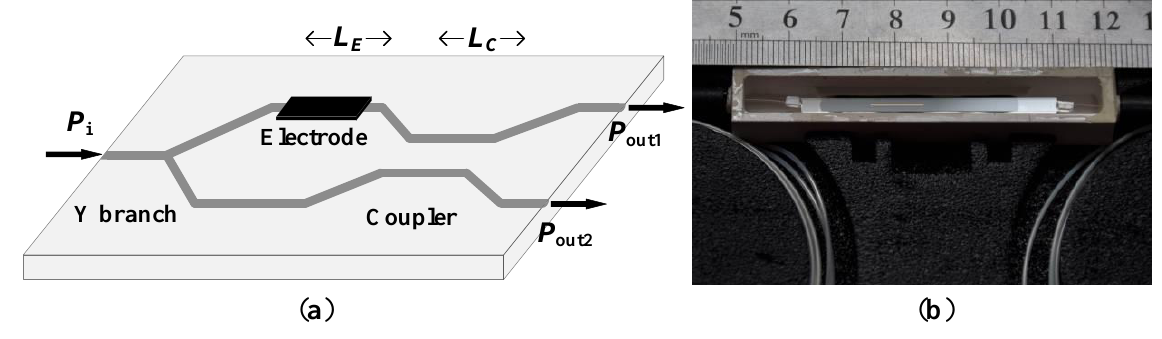
Figure 12. ( a ) Schematic of CI-based IOES; ( b ) Sensor after encapsulation.